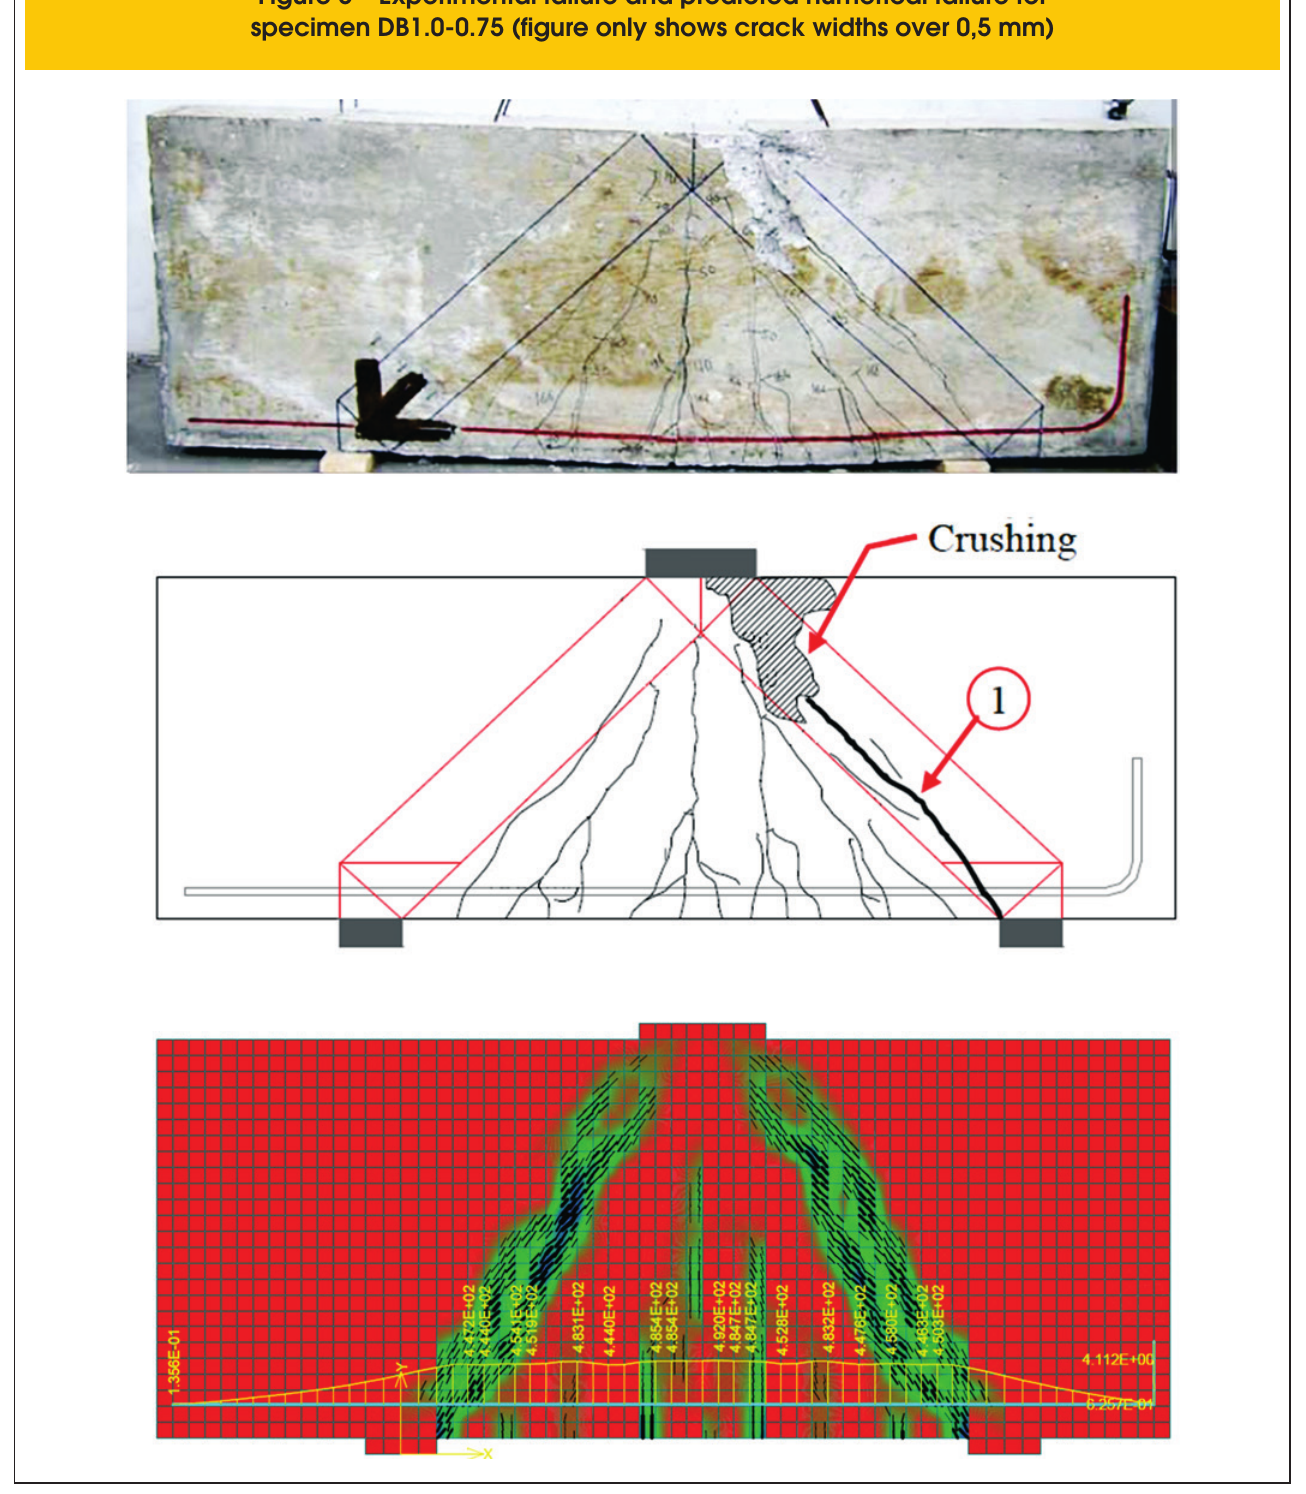
Figure 3 – Experimental failure and predicted numerical failure for specimen DB1.0-0.75 (figure only shows crack widths over 0,5